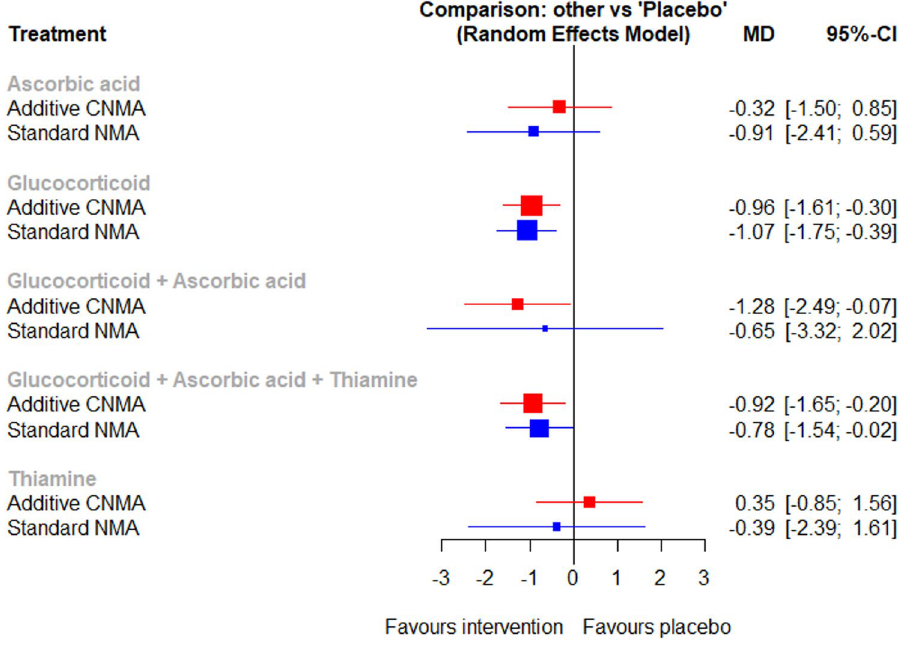
Figure 2. Network meta-analysis on time to resolution of